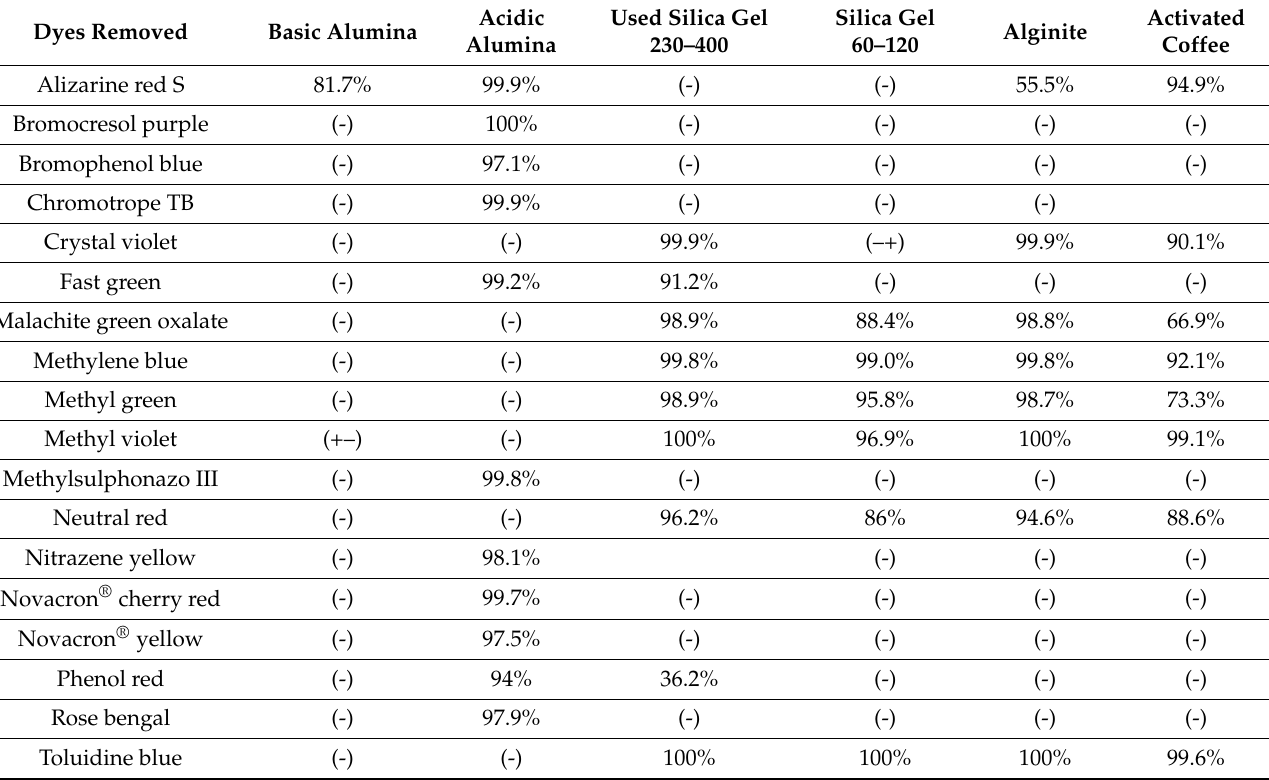
Table 3. Percentage removal of dyes on different adsorbent